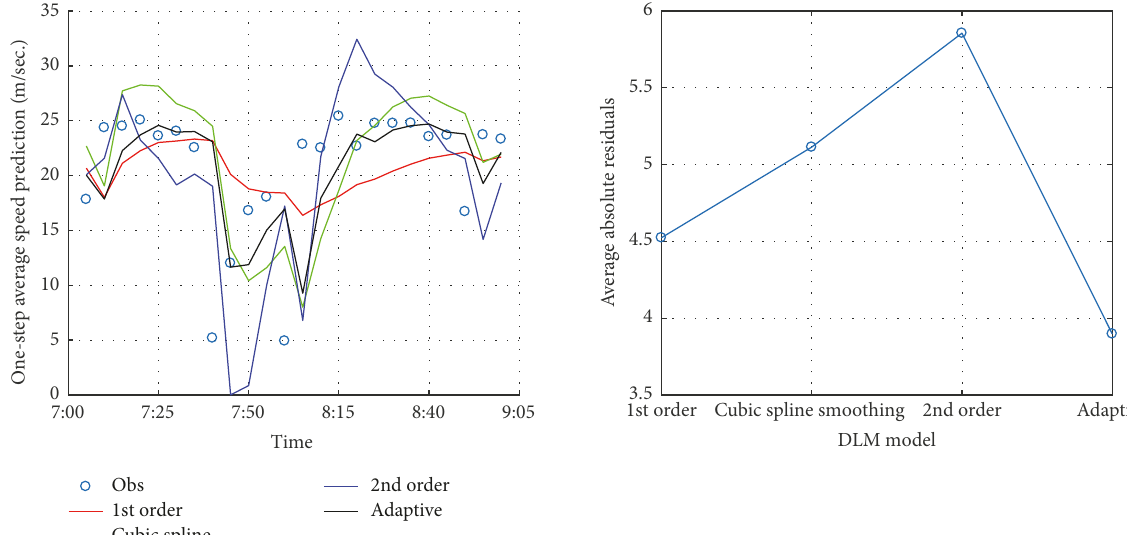
Figure 7: Comparison of the performance of different DLM models in unforeseen accident situation (road section